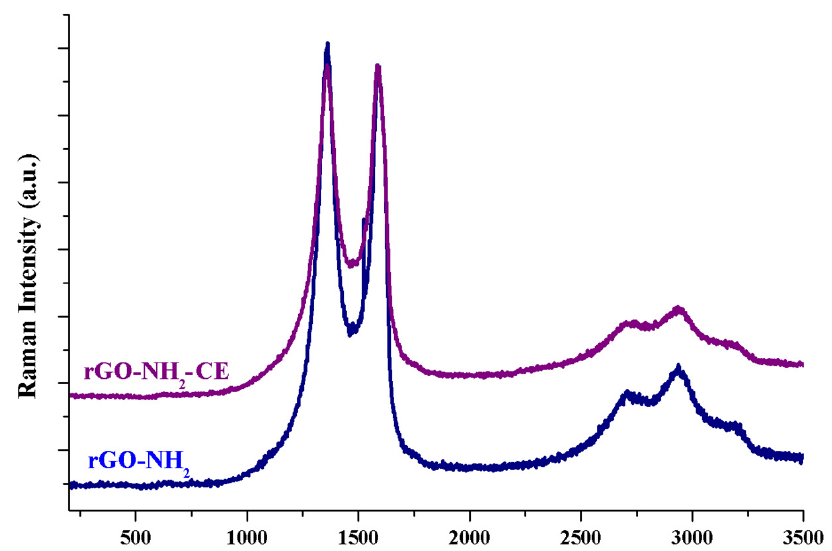
Figure 2. Raman spectra of rGO-NH 2 before and after functionalization with CE.